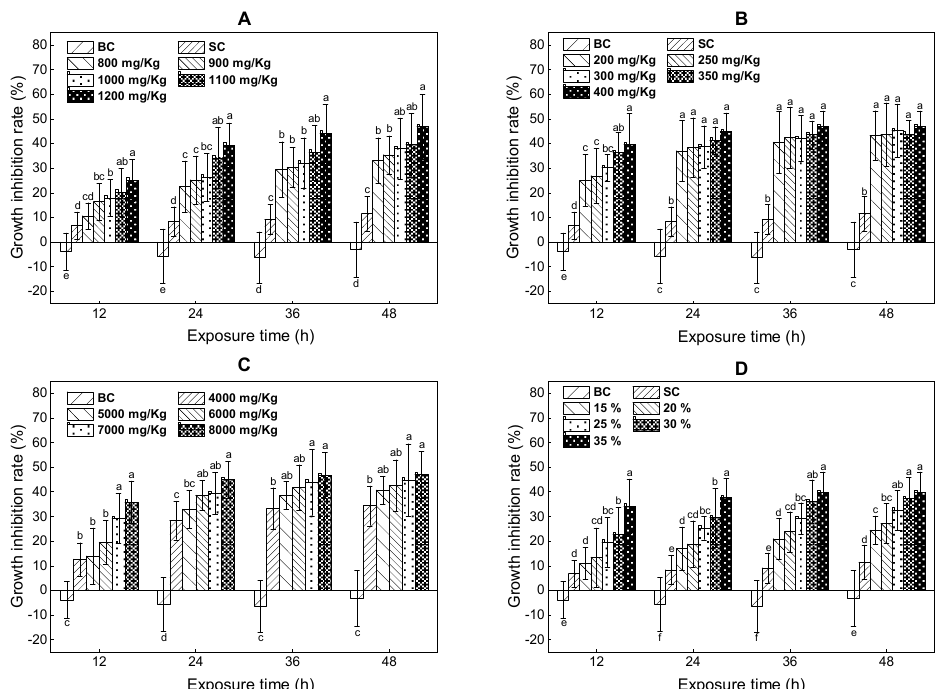
Figure 1. The growth inhibition rate of E. fetida exposed to toluene ( A ), xylene ( B ), trichloroethylene ( C ) and ternary mixture ( D ) for 12, 24, 36, and 48 h; BC represents blank controls; SC represents solvent controls; Different lowercase letters indicate significant differences among treatments.